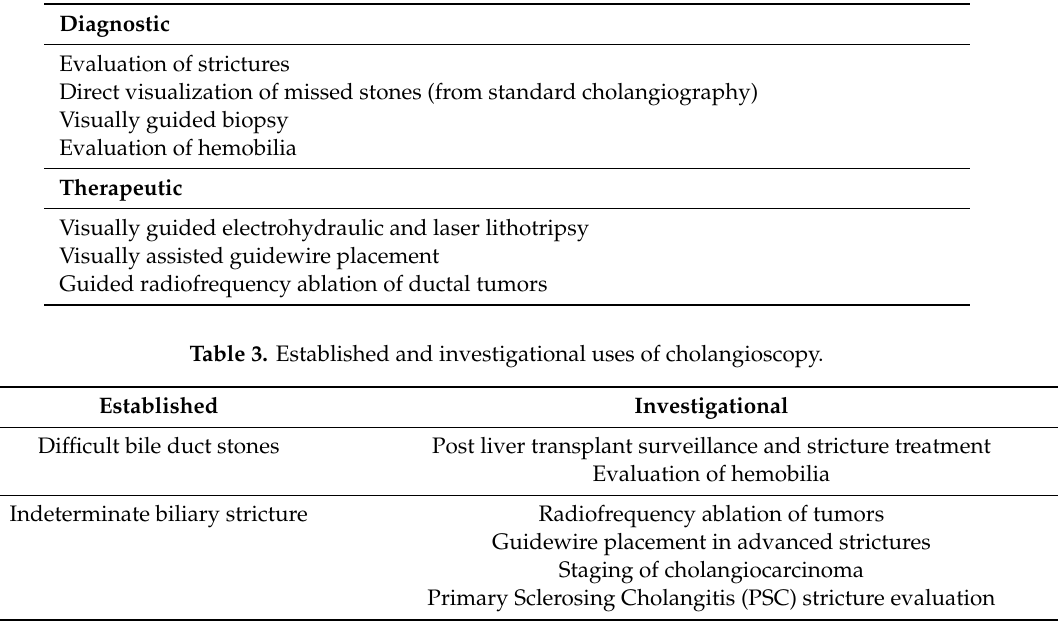
Table 2. The diagnostic and therapeutic benefits of cholangioscopy.